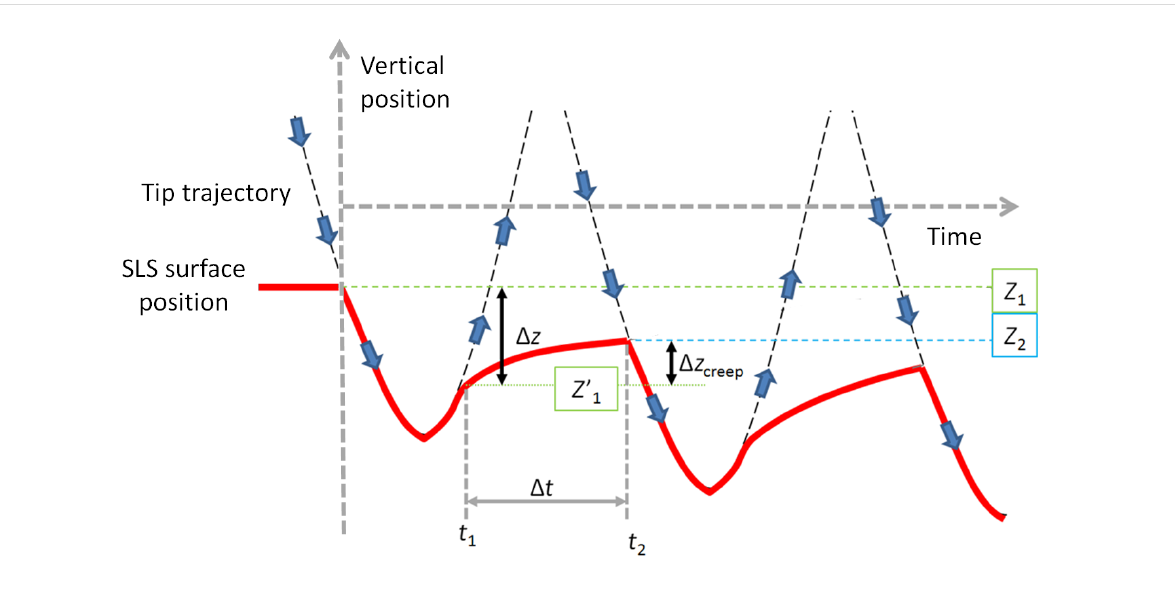
Figure 4: Illustration of the surface depression by the tip–sample impact, and successive recovery within the standard linear solid model. Z 1 is the undisturbed surface position, before any impacts have taken place. Z’ 1 is the vertical tip position where tip–sample contact is lost after the first impact (loss of contact occurs because the surface recovery speed is lower than the tip speed). Between the first and second impacts the tip recovers to pos- ition Z 2 . If the tip continues tapping at the same surface pixel, the impact and loss-of-contact locations asymptotically approach constant values.